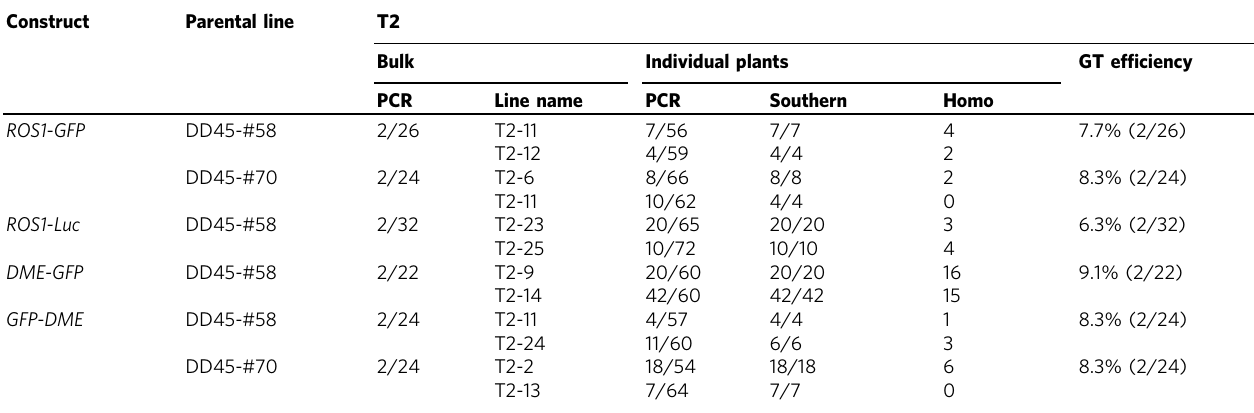
Table 1 Knock-in GT ef fi ciencies for the ROS1 and DME loci